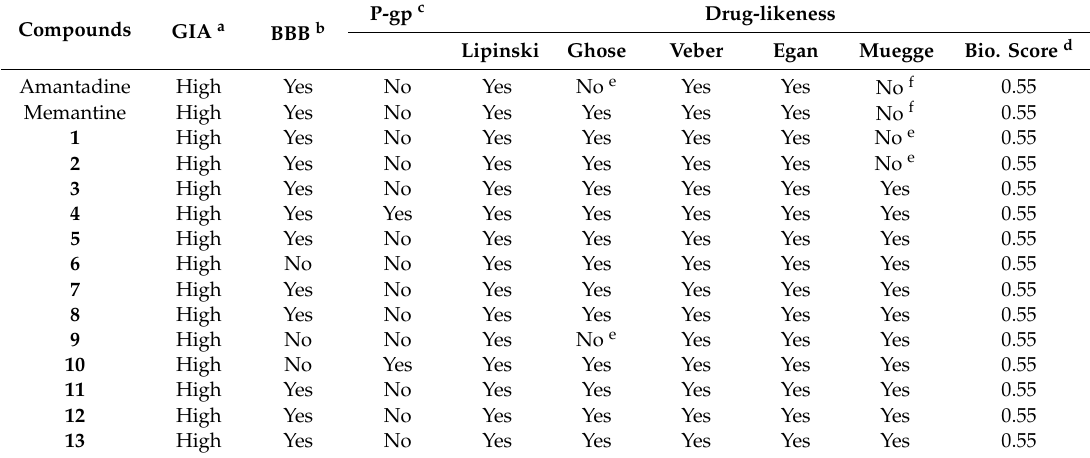
Table 3. In silico ADME and drug-likeness properties of memantine, amantadine and compounds 1 – 13 .